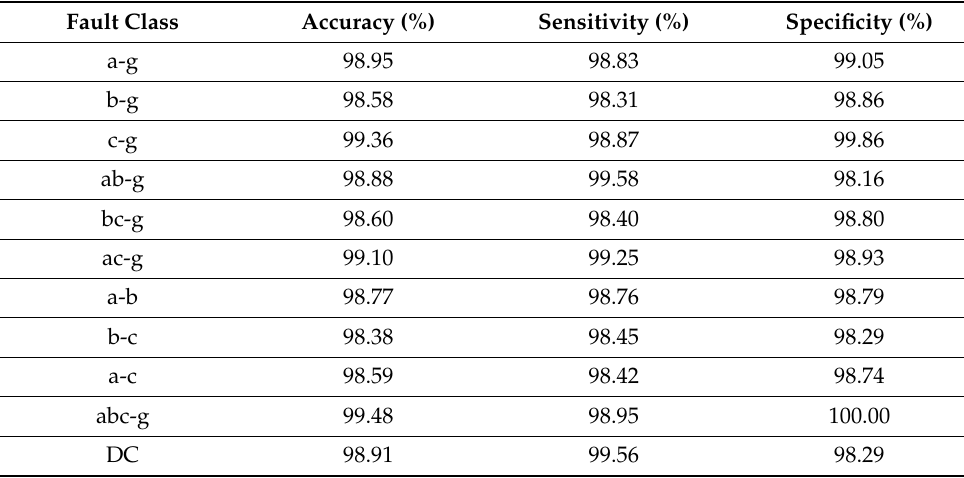
Figure 8 is a graphical depiction of these